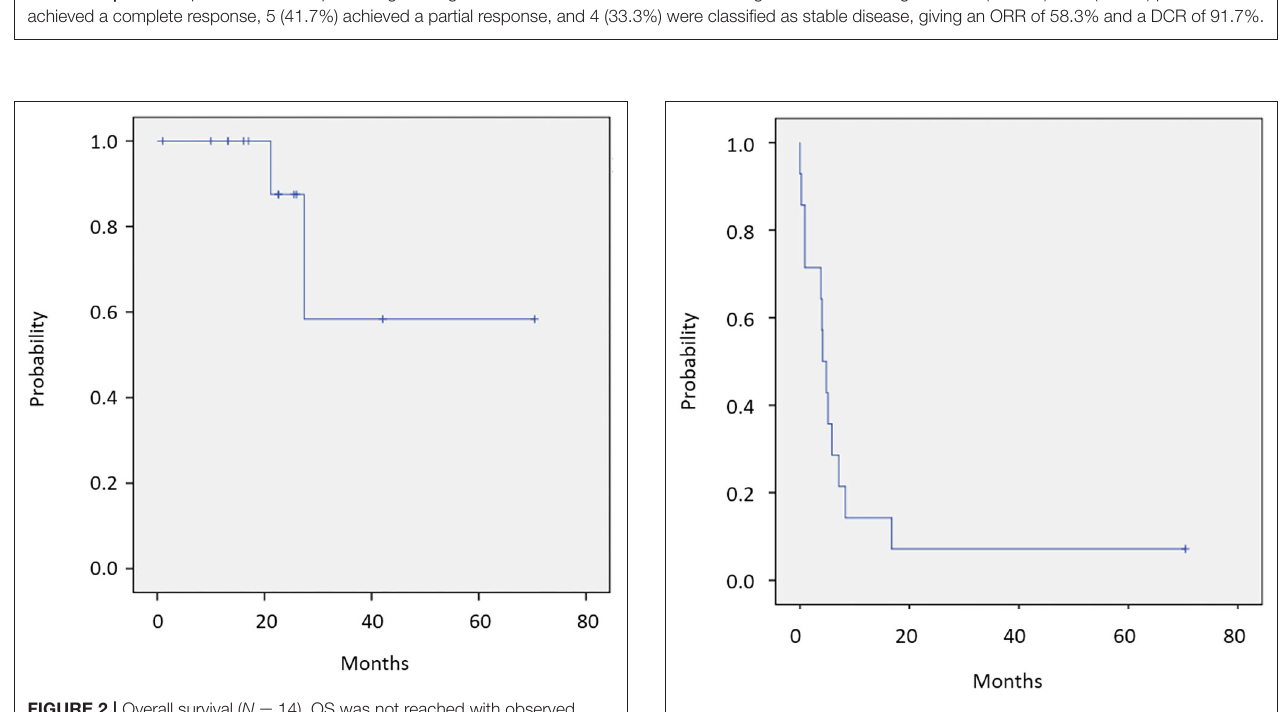
considered an option but may affect patient QoL because of the severe nausea caused by CDDP and the need for deep vein catheterization for 5FU, which, in many cases, requires